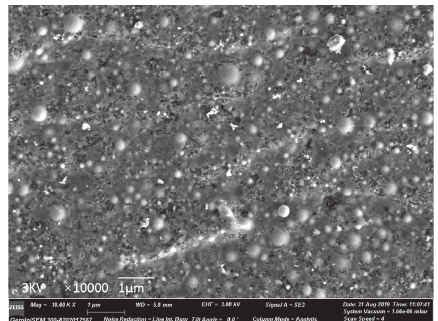
Figure 9: SEM micrograph showing the encapsulation of unhydrated particles within the EP membrane in specimen b5 at 10000x magnification.